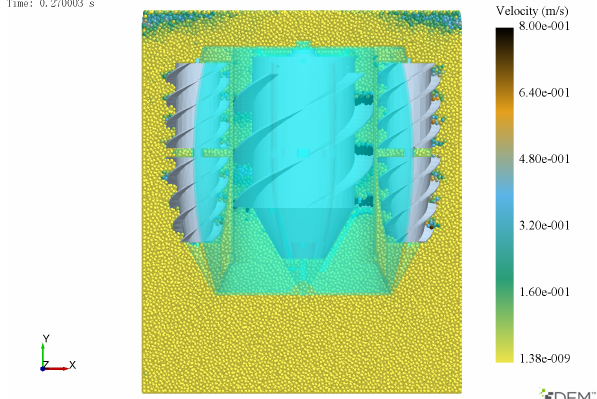
Table 5. Experiment factors and experiment number